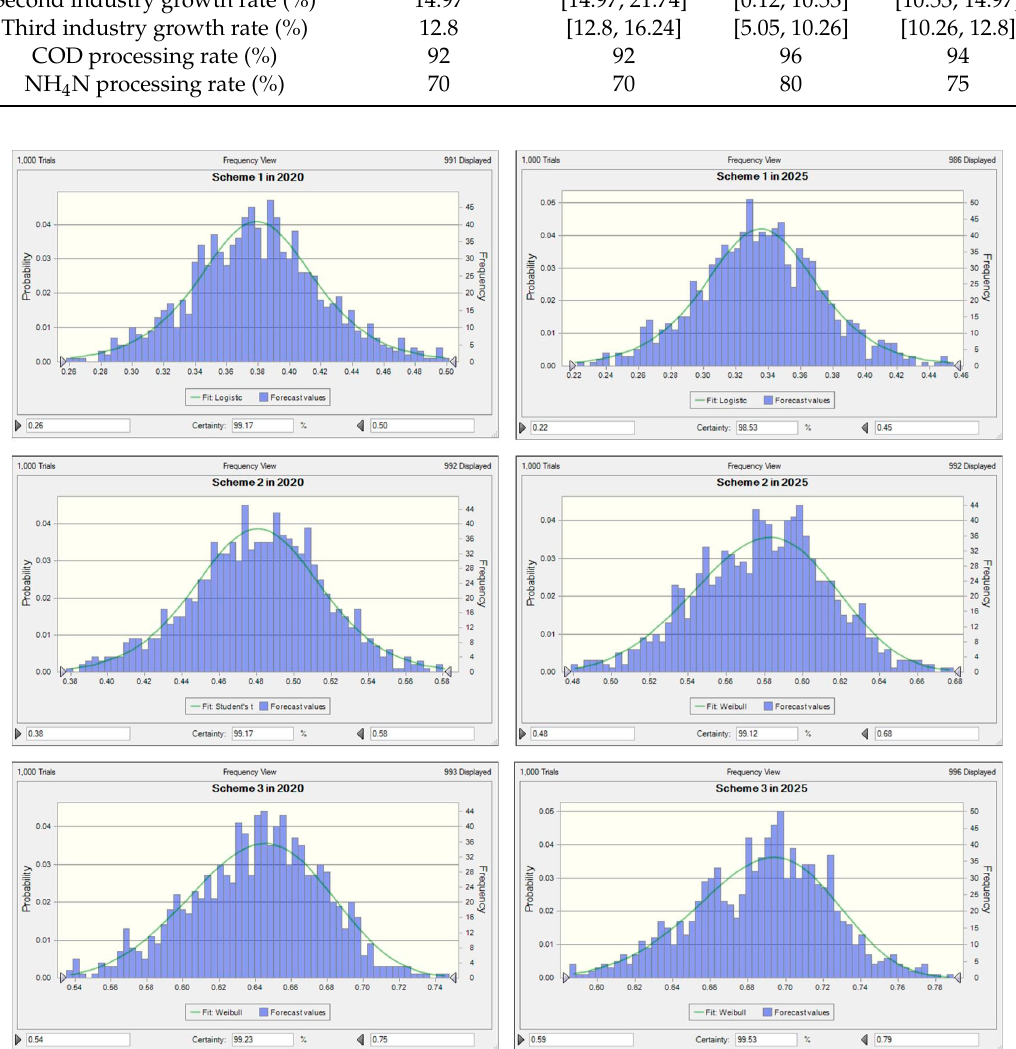
Figure 7. Probability distribution characteristics of the WECC indices of Scheme 1, Scheme 2, and Scheme 3 in 2020 and